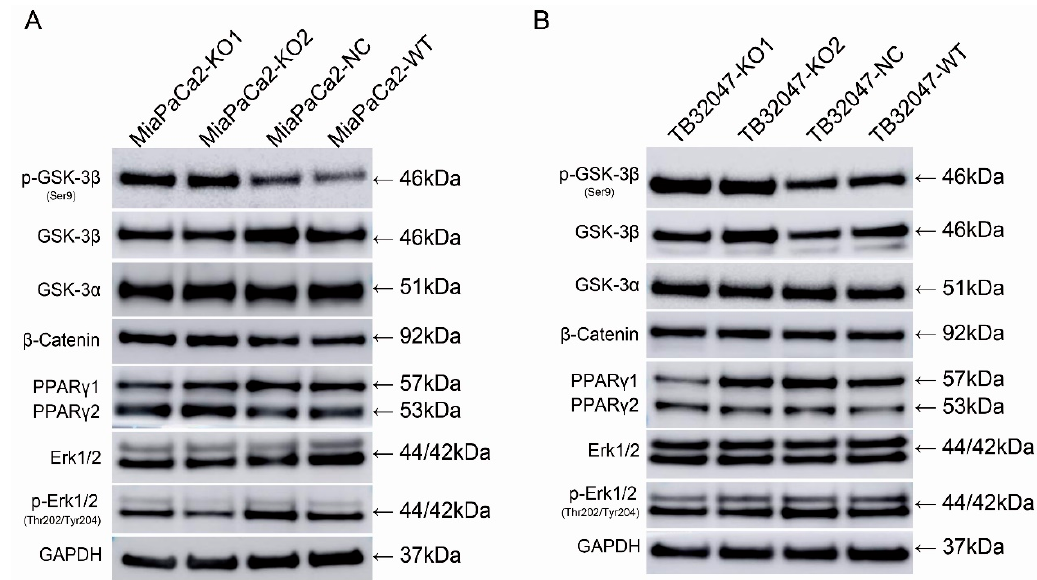
Figure 5. Knockout of GPRC5a promotes the phosphorylation of GSK-3 β at Ser9. ( A , B ) shows GSK-3 β and its related upstream and downstream protein expression with GPRC5a knockout in MIA PaCa-2 and TB32047, respectively.